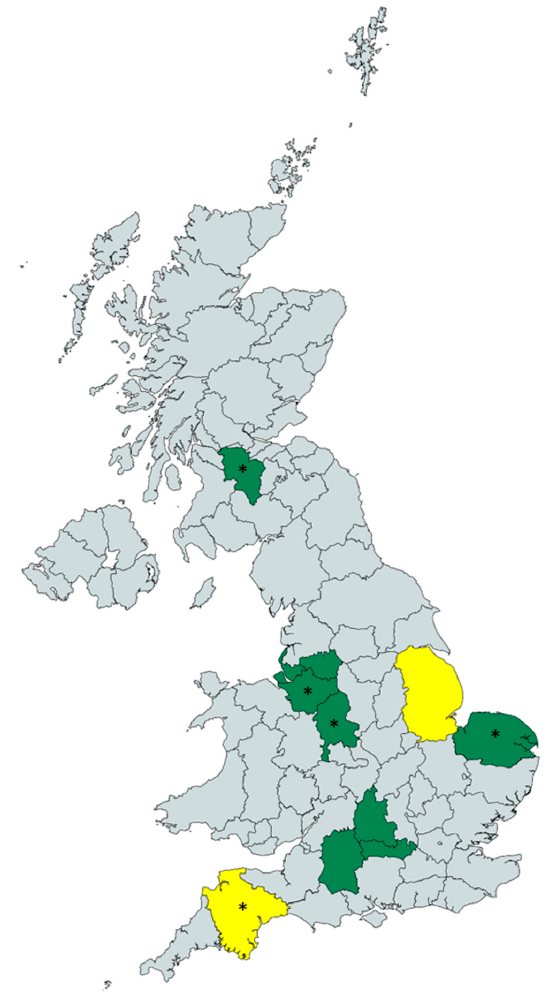
Figure 1. UK map showing the areas included in the study. Unwashed root vegetables ( n = 74) were collected from 18 different farm shops and A. fumigatus were recovered from the green highlighted counties, whereas no A. fumigatus growth was detected from samples collected in the yellow highlighted counties. Azole-resistant non- fumigatus spp. were recovered from the counties with an asterisk. The map was created using mapchart.net.